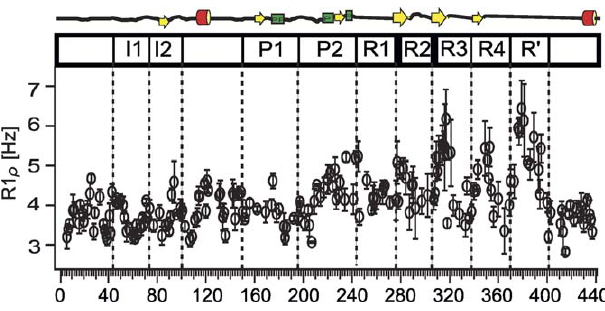
Figure 6. Intrinsic Flexibility of Tau Plot of 15 N R 1 q spin relaxation rates along the amino acid sequence. High